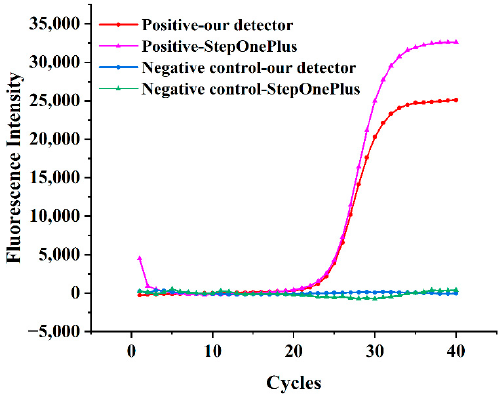
Figure 9. Real-time fluorescence PCR curves for detection of Legionella pneumophila and negative control from our detector and StepOnePlus system.